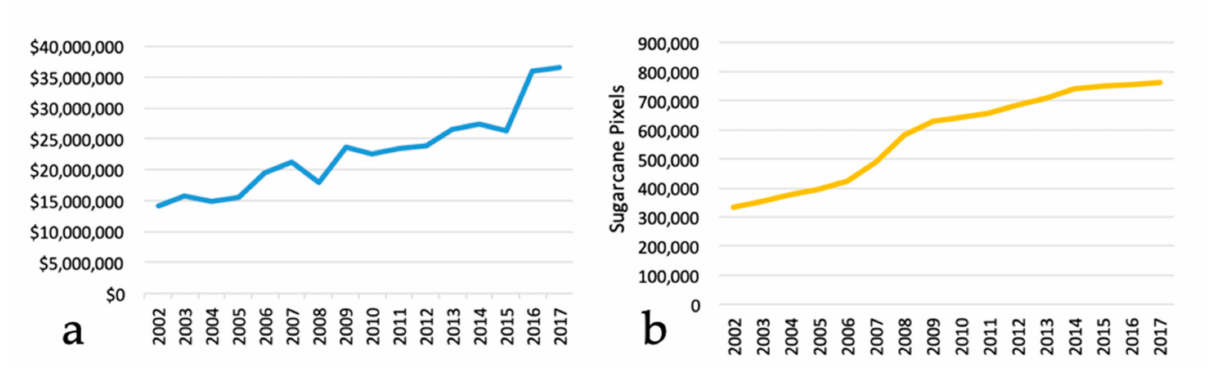
Figure 11. Yearly growth trends for GVA of agriculture and sugarcane: ( a ) cumulative yearly gross value added (GVA) of agriculture for S ã o Paulo in Brazilian Real (R); ( b ) count of sugarcane pixels detected by